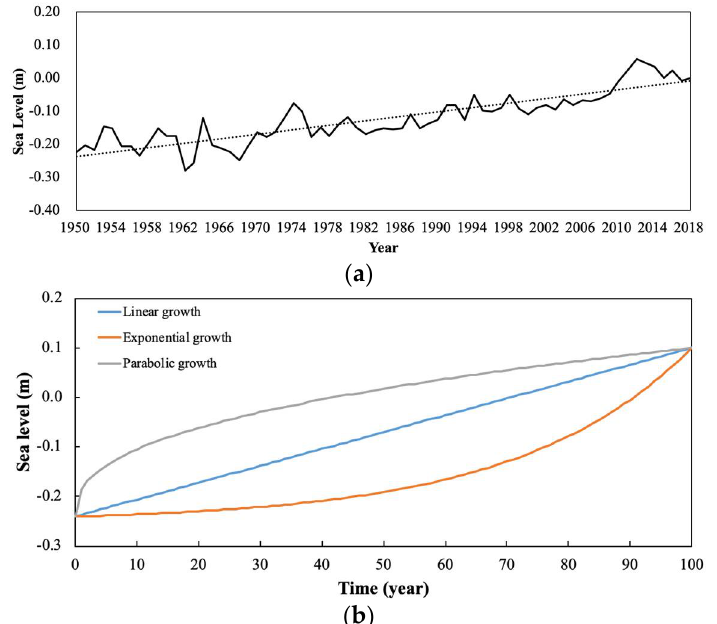
Figure 12. ( a ) The observed sea level rise at the Tanggu tide station and ( b ) three types of sea level rise variation processes with the same sea level at the beginning and end of the period from 1950 to 2018 were used for the simulation.